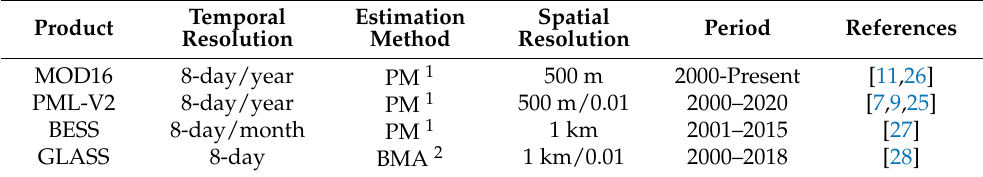
Table 2. Characteristics of the remote sensing data and methods used in this